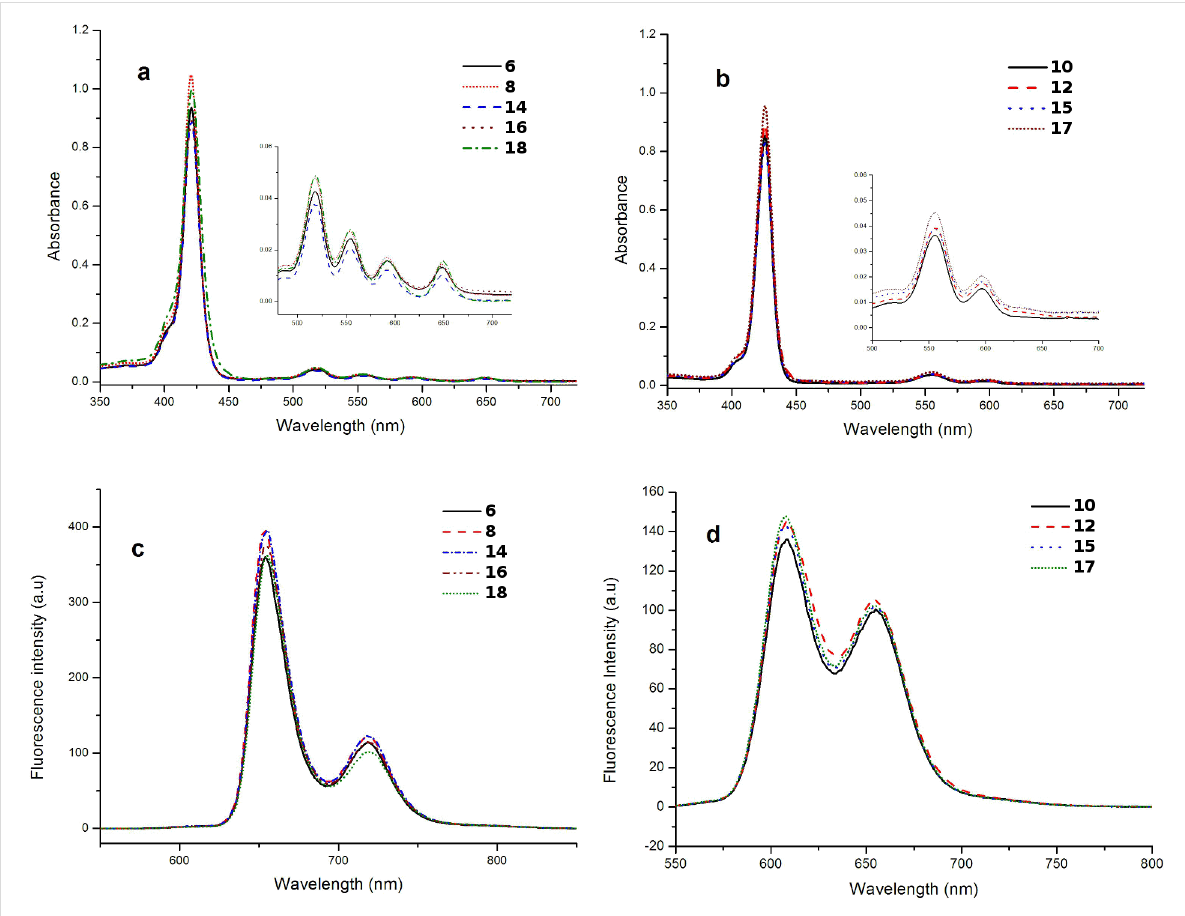
Figure 1: (a) Electronic absorption spectra of free-base porphyrins 6, 8, 14, 16 and 18 in CHCl 3 at 298 K. (b) Electronic absorption spectra of zinc porphyrins 10, 12, 15 and 17 in CHCl 3 at 298 K. Inset in both (a) and (b) shows the Q bands. (c) Fluorescence spectra of free-base porphyrins 6, 8, 14, 16 and 18 in CHCl 3 (2 × 10 − 6 mol L − 1 ) at 298 K, λ ex = 420 nm. (d) Fluorescence spectra of zinc porphyrins 10, 12, 15 and 17 in CHCl 3 (2 × 10 − 6 mol L − 1 ) at 298 K, λ ex = 420